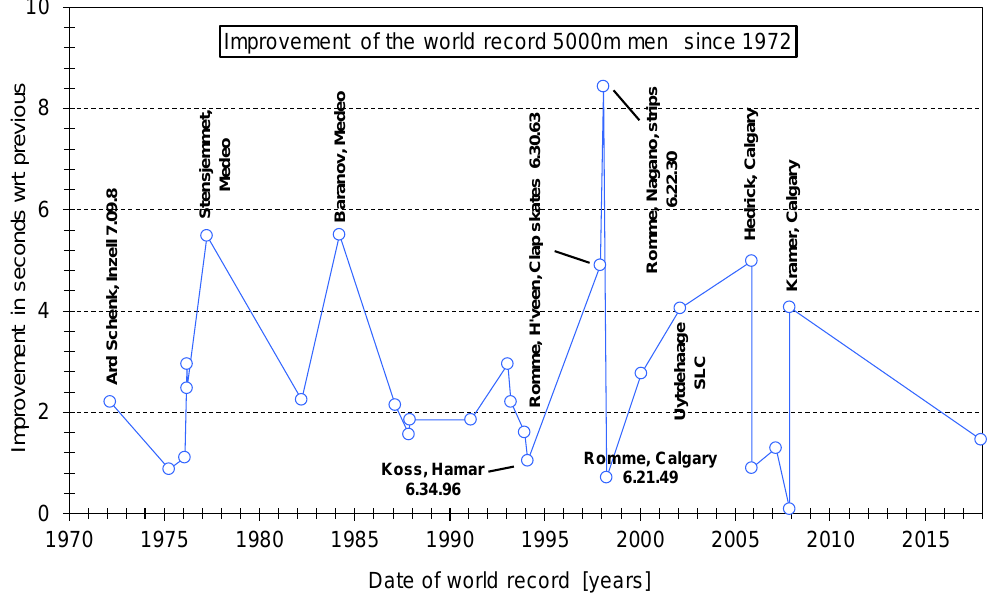
Figure 10. Incremental improvement in seconds of the 5000 m world record since 1972. In Figure 11, all of these incremental changes are put together, again with the starting point in 1972. The coordinates for the horizontal axis were computed according to the dates the records were skated: 15 February 1995 is 1995.126. The graph nicely depicts the development of the men’s 5000 m world record during the last four decades. Over the years, many factors have contributed to higher skating speeds—some in a gradual way, like improvements in nutrition, training methods (better understanding of the skating technique) and medical support; some in a small jump, such as the erection of indoor skat- ing rinks and the associated ice preparation; and others in a more abrupt way, such as innovations in skates and suits. If specific performance improvements follow an S-curve, Figure 11 can be seen as the sum of a continuous stream of S-curves with smaller or larger jumps on top of a generally increasing curve associated with learning and societal well- being.